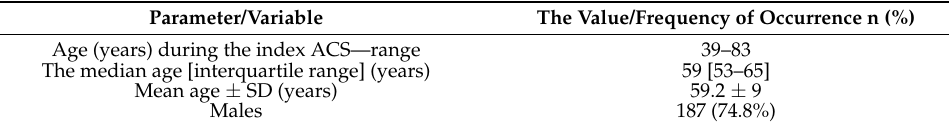
Table 2. Demographic data of the studied group.